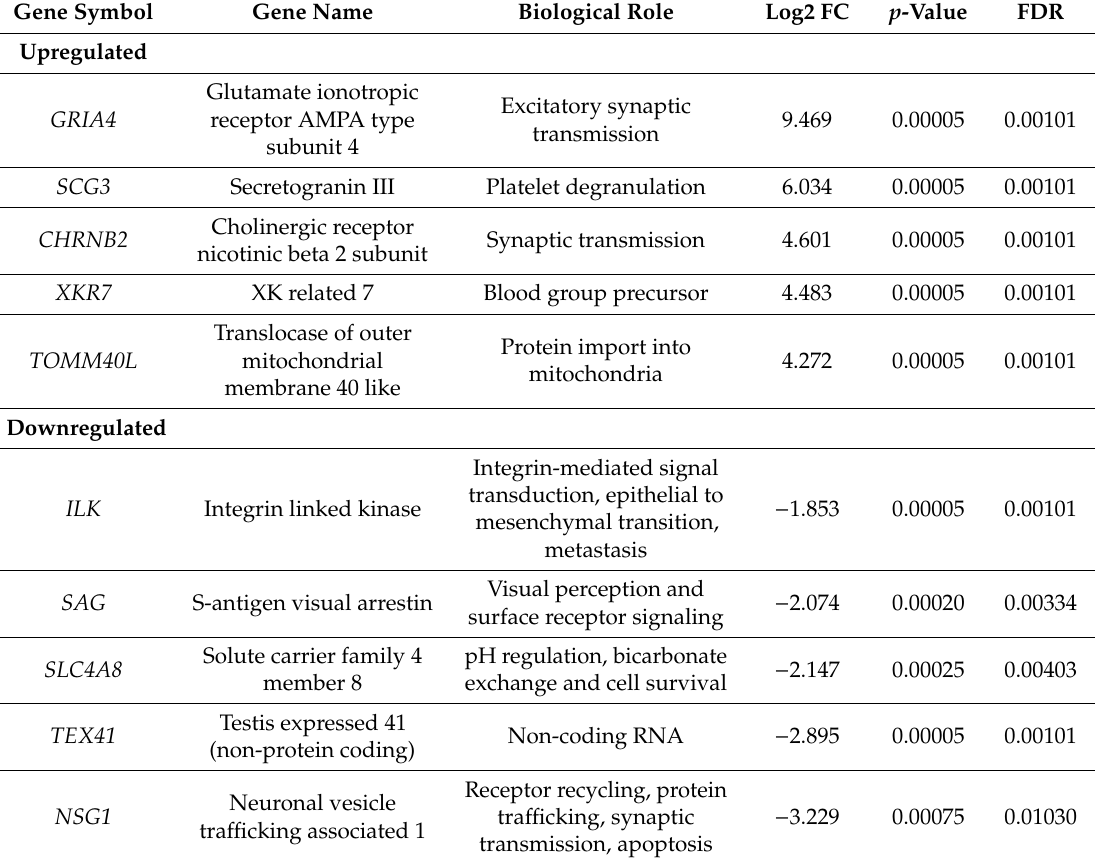
Table 3. Top 10 upregulated and downregulated genes in ILK-siRNA(2) vs.